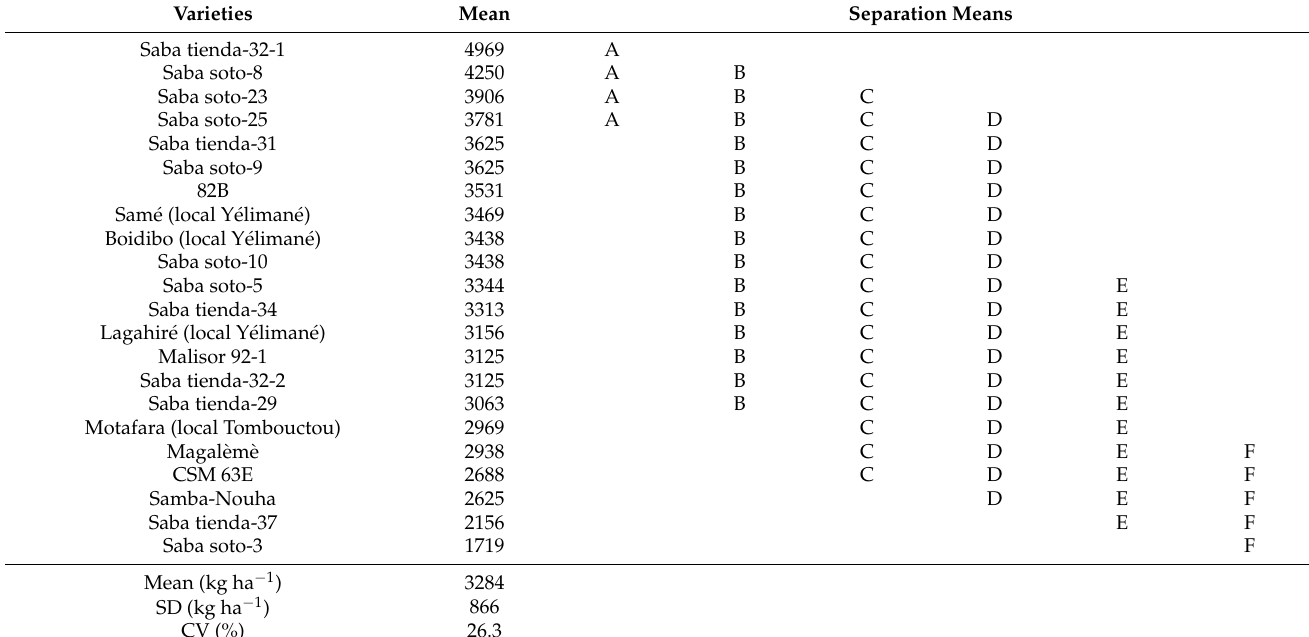
Table 5. Average sorghum straw yield (kg ha − 1 ) across sites of flood recession farming for 22 varieties tested in Yaguine, Gory, and Foungou in the 2014/2015 cropping season. Varieties with letters that do not overlap (A to F) are significantly different, according to a Newman–Keuls test.